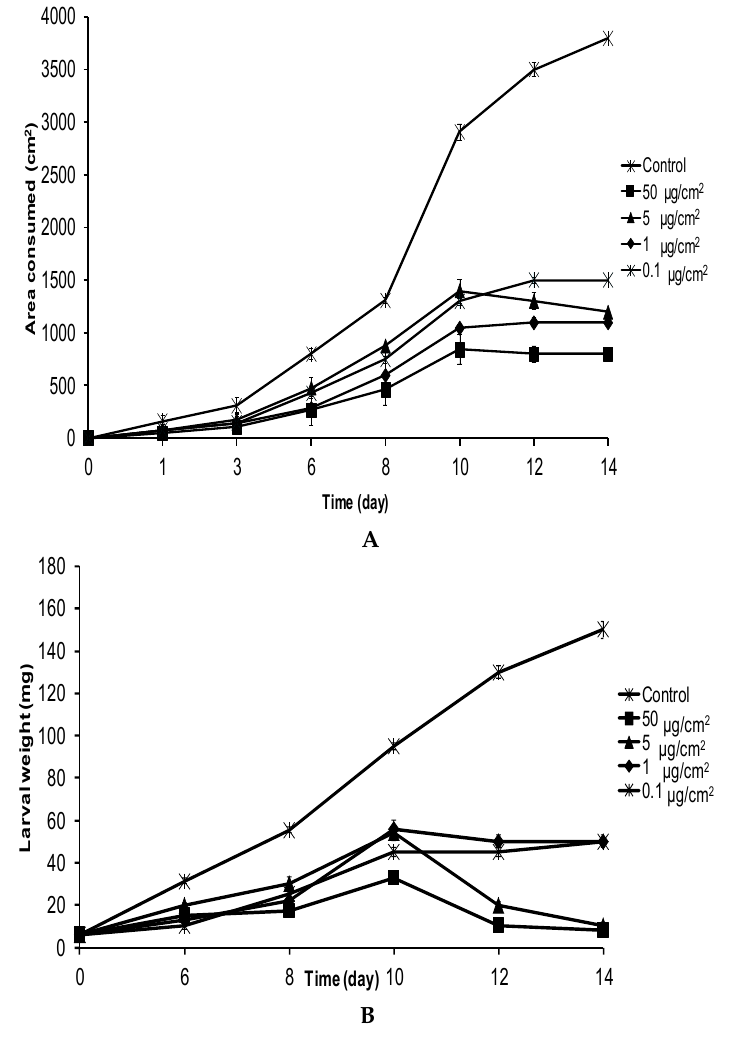
Figure 2. Average leaf area consumed ( A ) and average body weight ( B ) of S. frugiperda larvae fed on leaves treated with 1 in a no-choice feeding assay. Error bars <60 and <10 for area consumed and body weight, respectively, are embedded in symbols. Table 2. Lethal time (LT 50 ) of 1 against Spodoptera frugiperda and Epilachna paenulata in mortality test. LT 50 in Days (Values and 95% Confidence Interval) Dosage µ g/cm 2